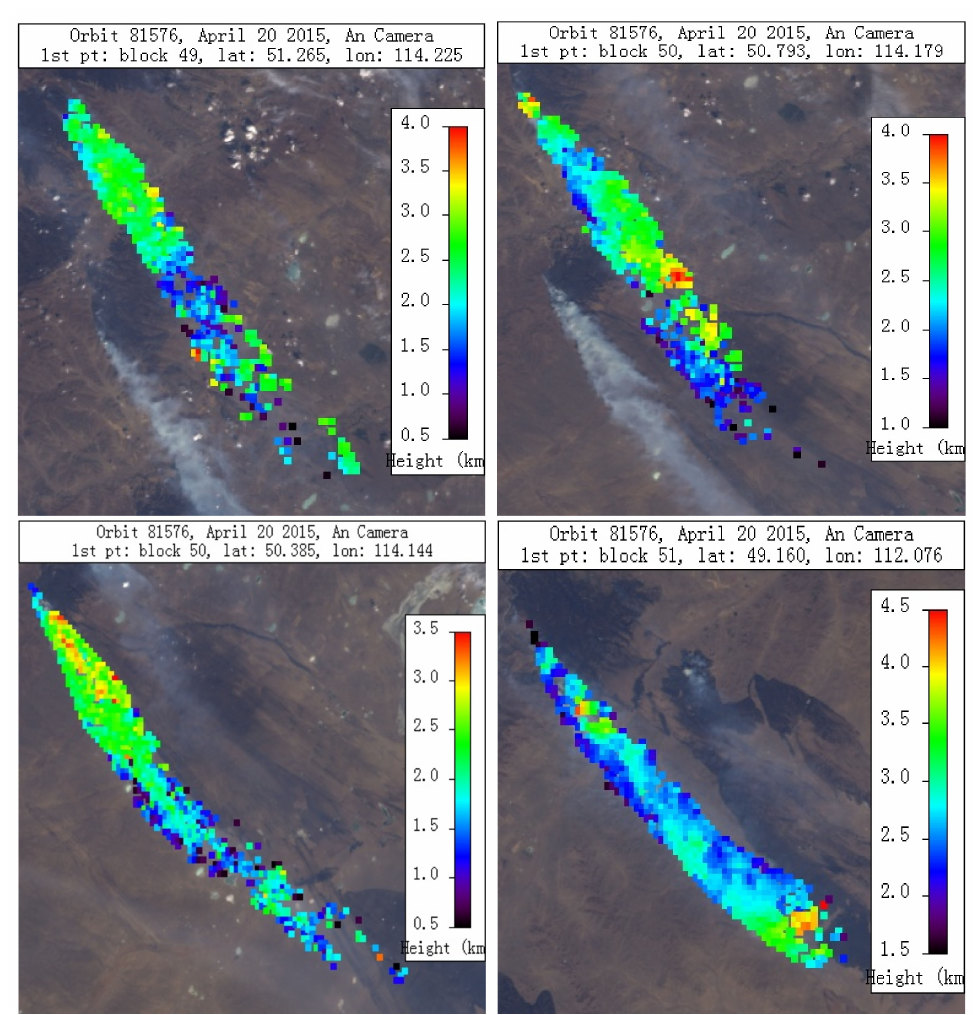
Figure 3. Height of smoke plume sketches derived from Multi-Angle Imaging Spectroradiometer (MISR) data by employing MISR Interactive Explorer (MINX) v4.0